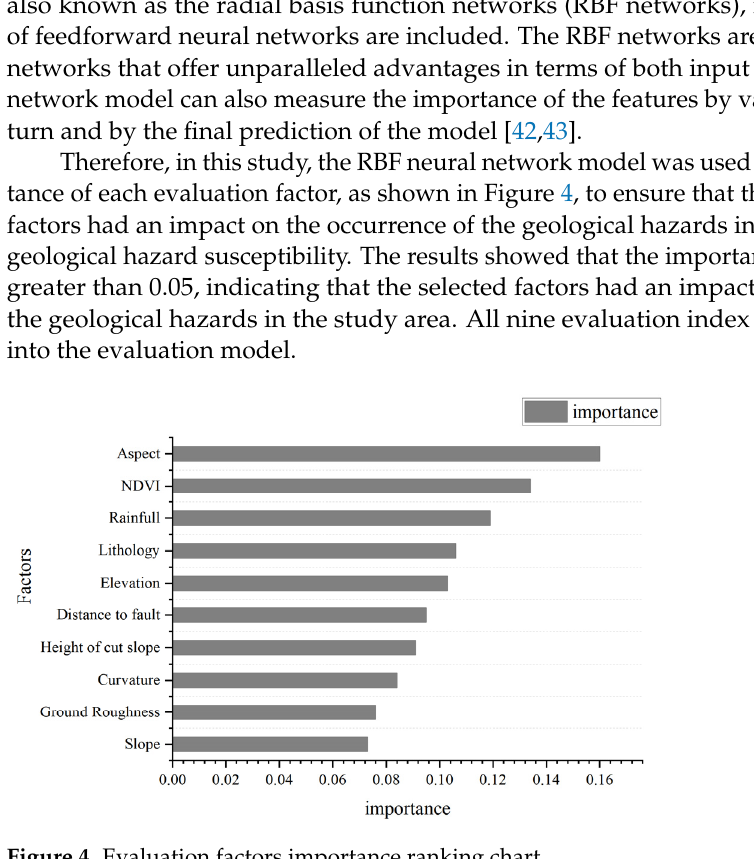
Figure 4. Evaluation factors importance ranking chart.